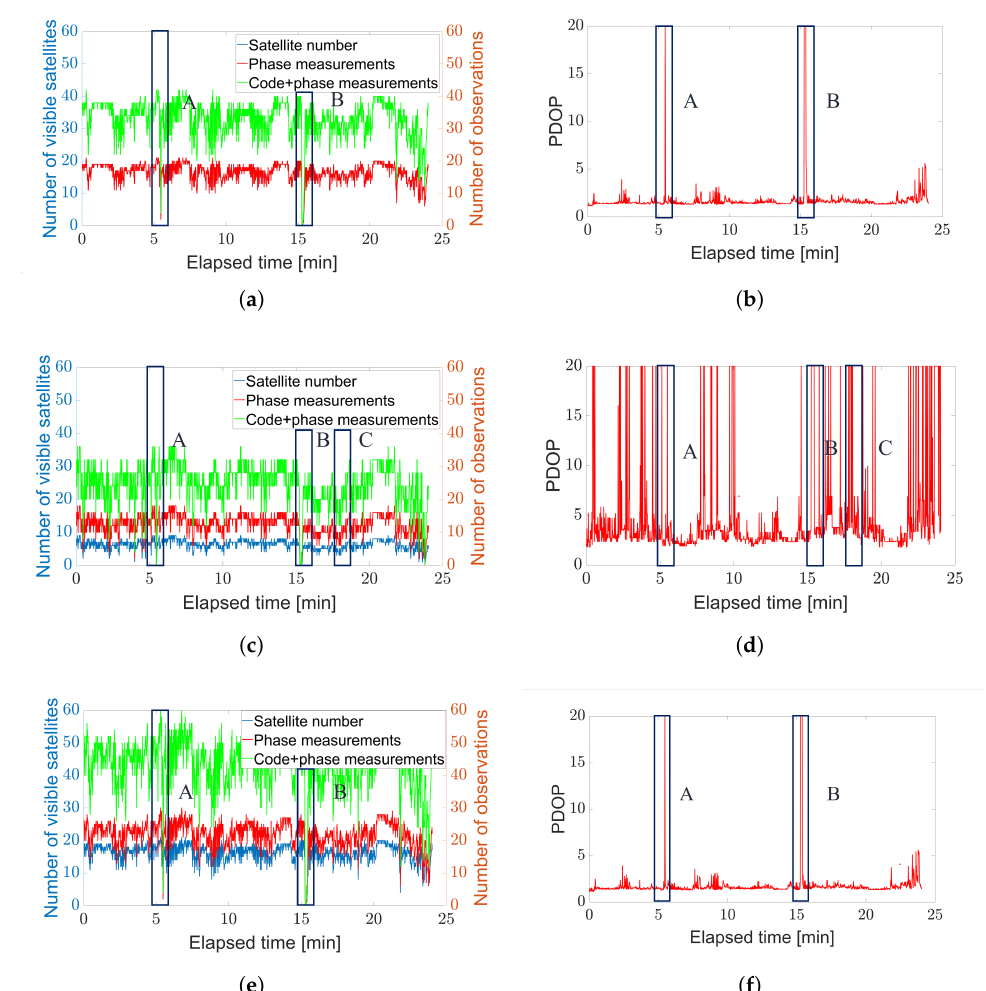
Figure 13. Time series of the number of satellites, observations, and PDOP in three processing strategies. ( a ) Time series of the number of satellites and observations in SF processing. ( b ) Time series of PDOP in SF processing. ( c ) Time series of the number of satellites and observations in DF processing. ( d ) Time series of PDOP in DF processing. ( e ) Time series of the number of satellites and observations in SFDF processing. ( f ) Time series of PDOP in SFDF